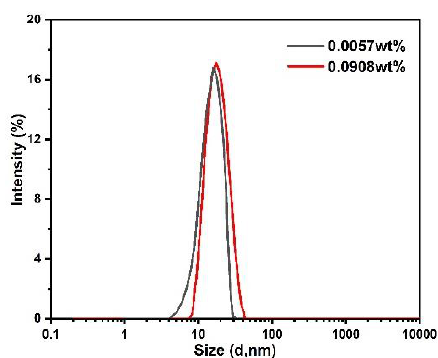
Figure 6. Size distribution of nanoparticles in TiO 2 nanofluid.